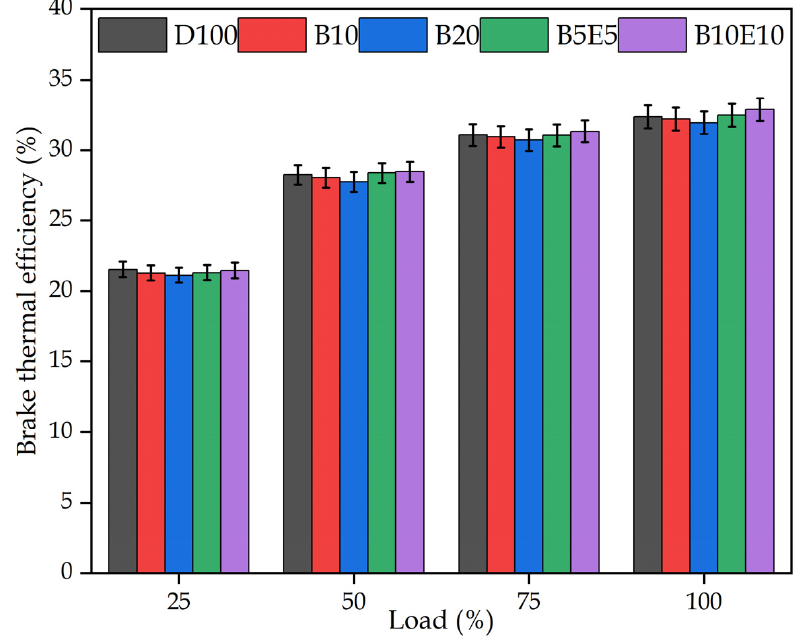
Figure 8. BTE of various fuel blends against engine load.